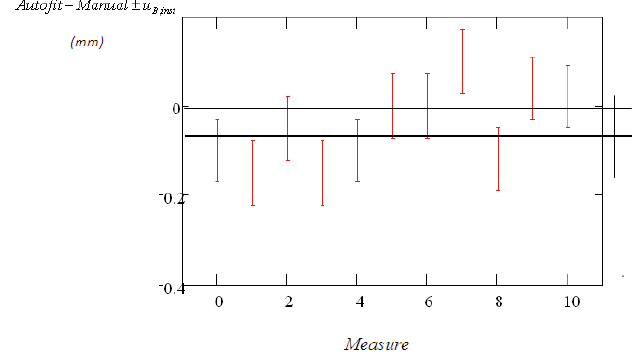
Fig. 3. Apparent differences between results of two measure- ment methods (“Autofit” and “Manual”) for a series of gap